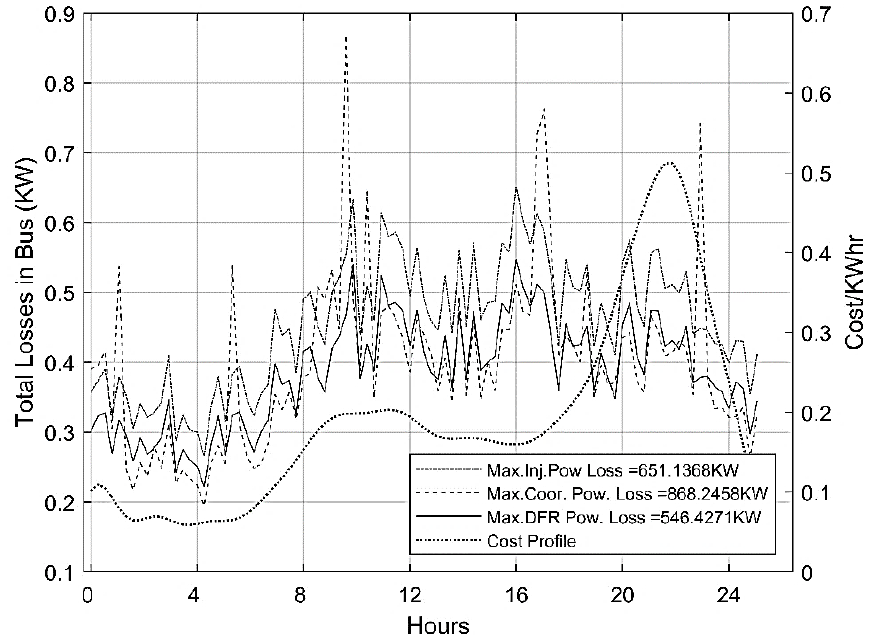
Figure 6. Total power losses comparison of three techniques.